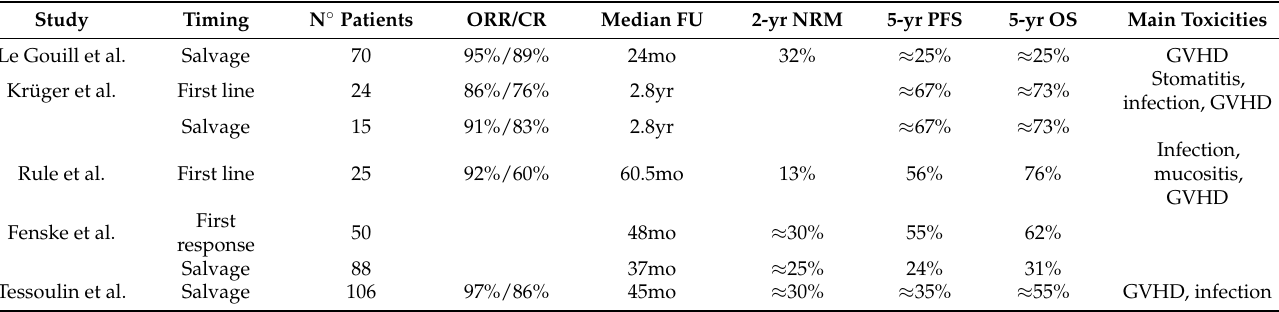
Table 1. Comparison between studies showing allo-SCT as consolidation of the first or subsequent lines of treatment.